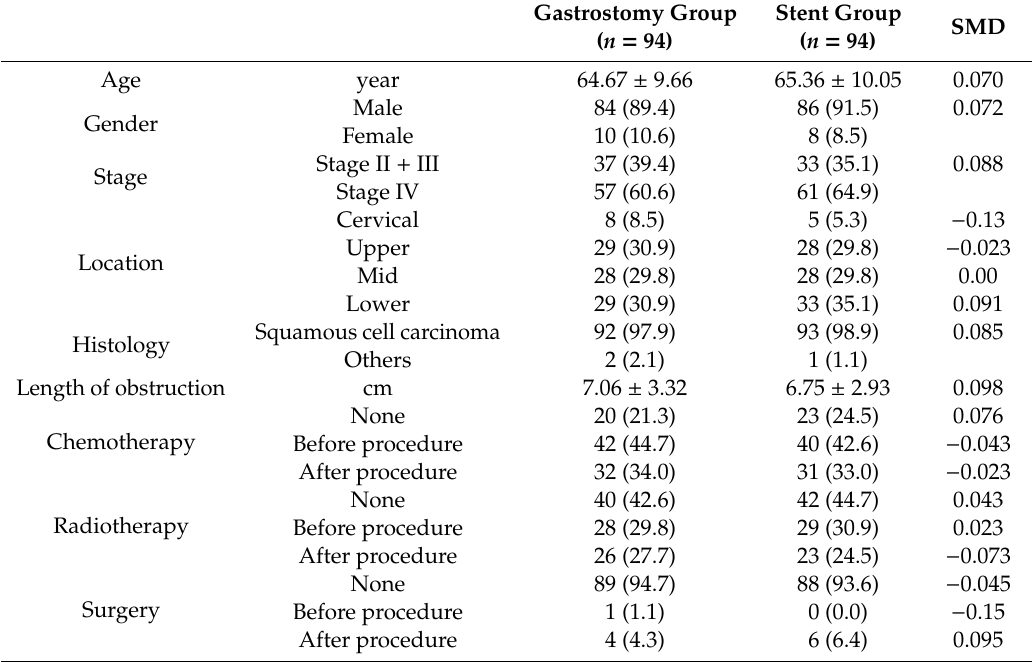
Table 2. Baseline characteristics of patients with malignant esophageal obstruction undergoing gastrostomy and stent insertion, after propensity score matching (94 matched